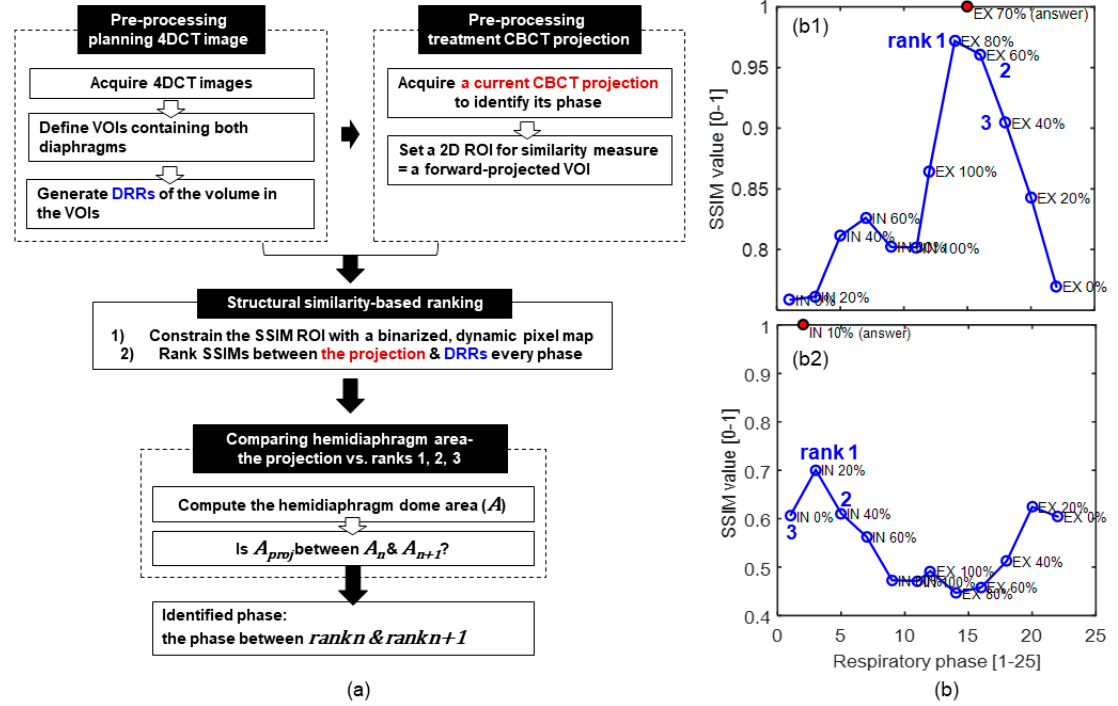
Figure 1. Pipelines for respiratory phase identification. As shown in ( a ), after preprocessing the image, the current respiratory phase was determined using an image similarity test and the area of the diaphragm. ( b ) Representative structural similarity (SSIM) rank profiles as a function of the respiratory phase.